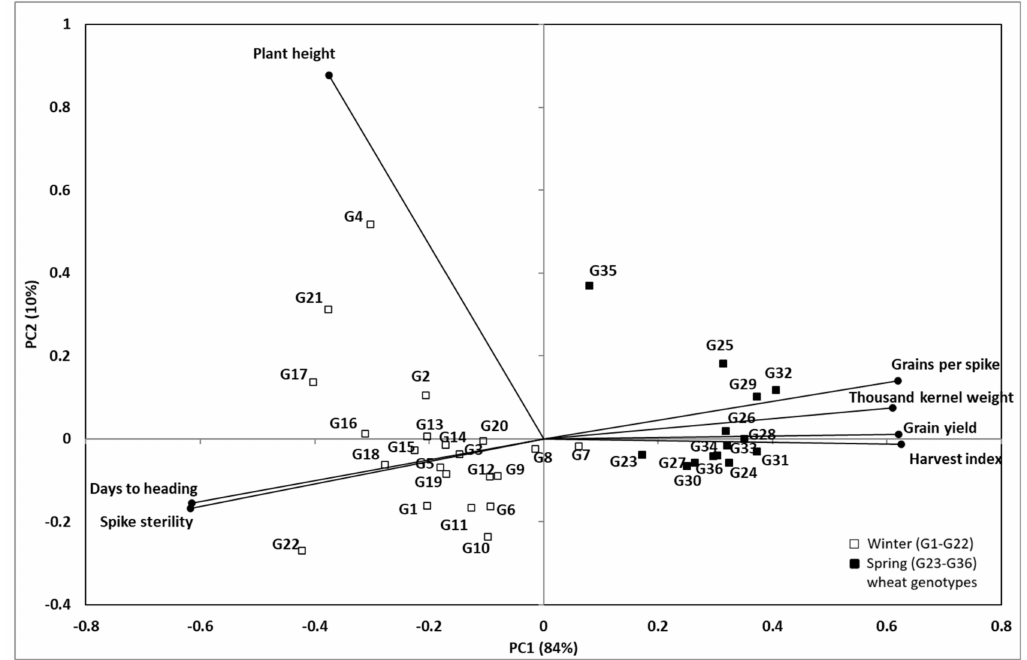
Figure 10. Biplot depicting relationships between plant characteristics and genotypes. G stands for genotype codes given in Table